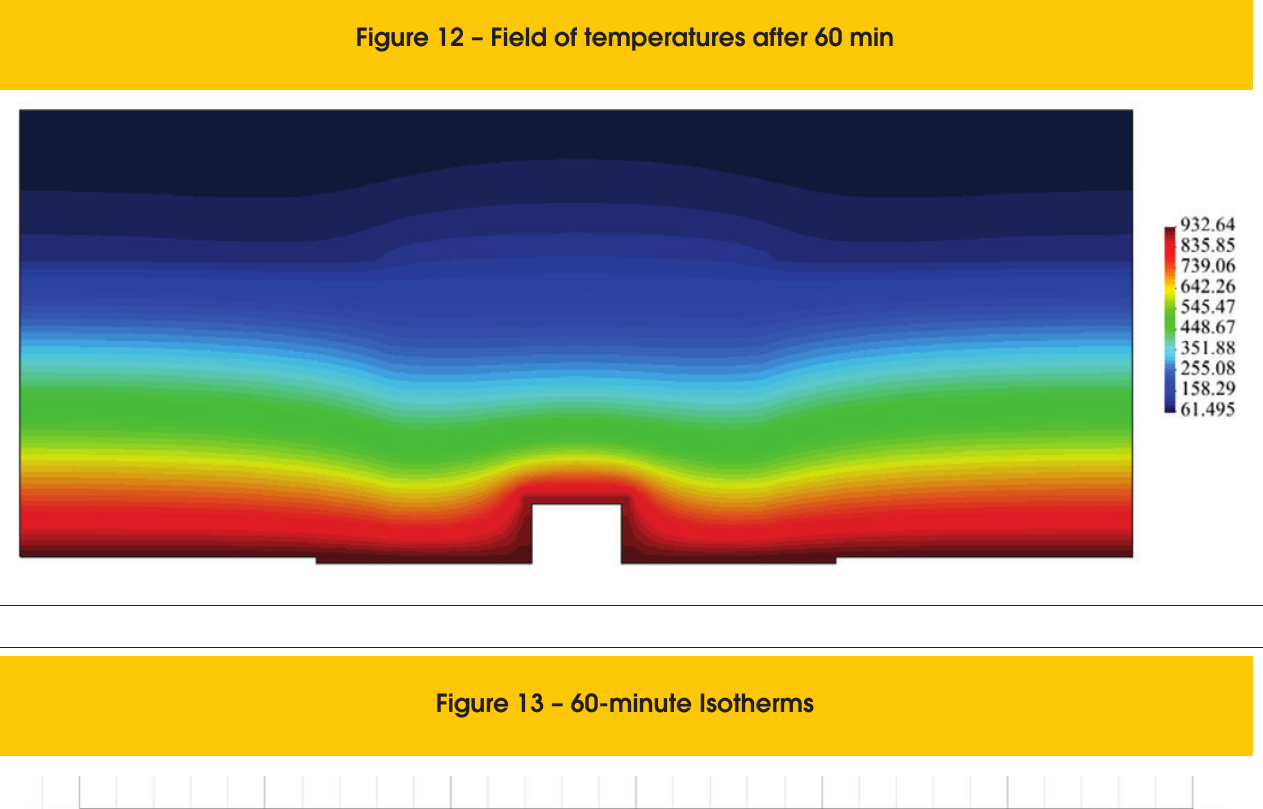
Figure 12 – Field of temperatures after 60 min